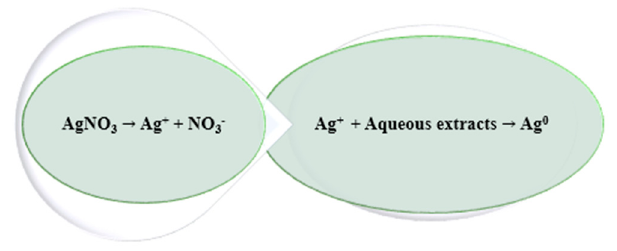
Figure 2. Schematic synthesis of AgNPs and reduction of Ag + ions to Ag 0 .